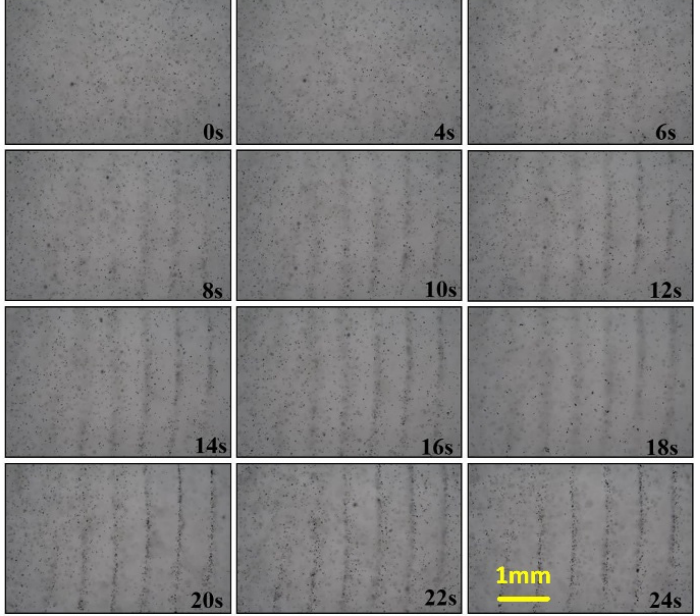
Figure 9. Recordings illustrating the process of particle arrangement actuated by the IEM mode with 1 MHz.